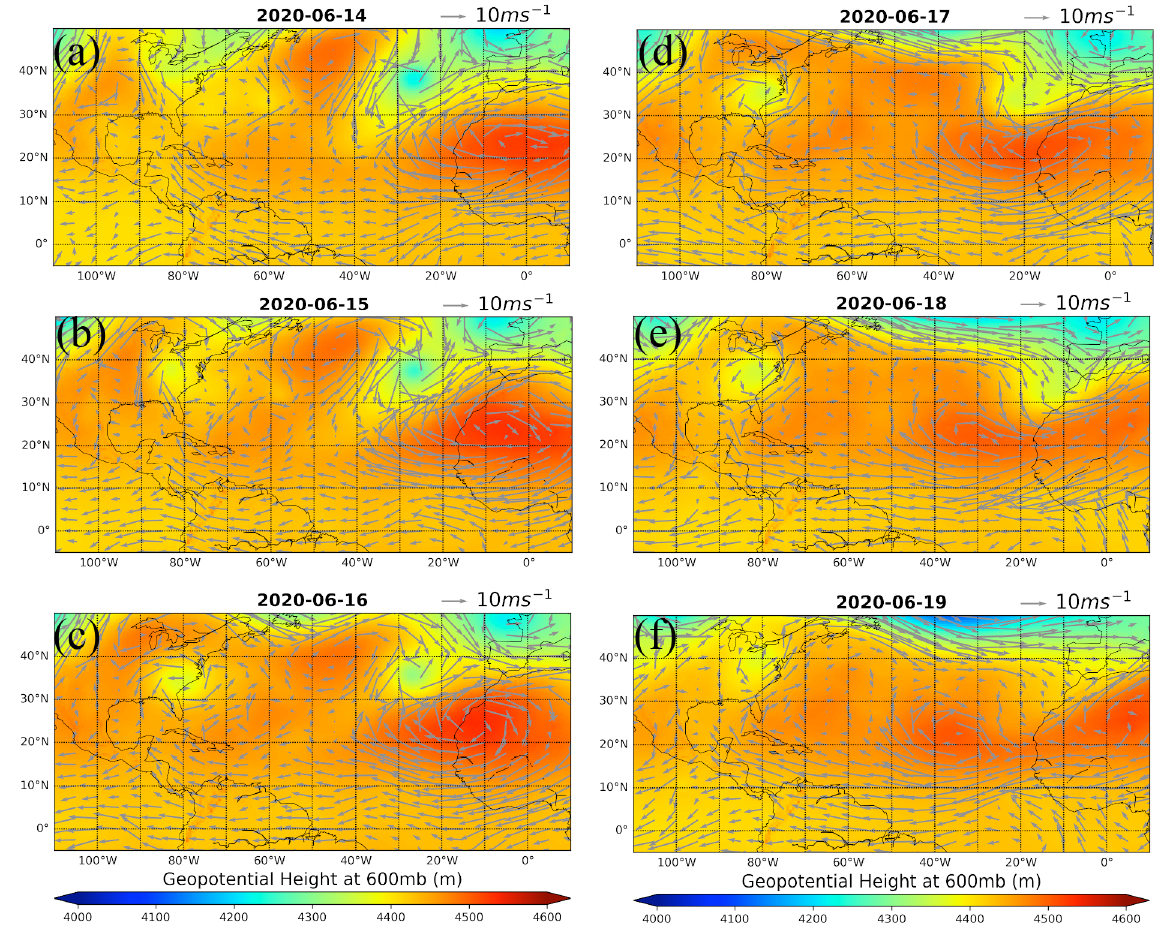
Figure 10. Patterns of MERRA-2 geopotential height (color) and wind vector (gray arrow) at the 600hPa level on 14 (a) , 15 (b) , 16 (c) , 17 (d) , 18 (e) , and 19 June (f)